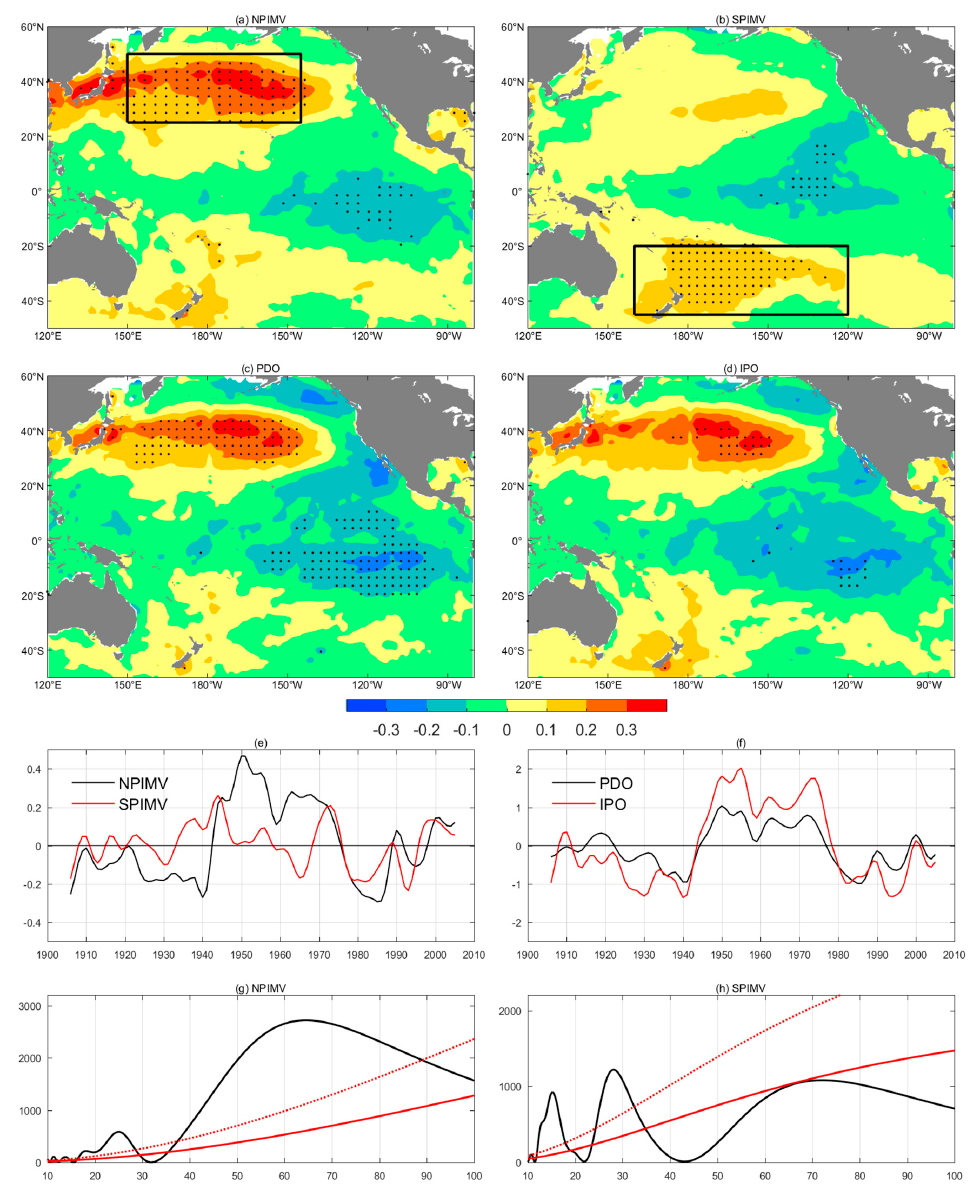
Figure 2. Regressions of SST anomalies onto ( a ) the NPIMV index, ( b ) the SPIMV index, ( c ) the Pacific decadal oscillation (PDO) index, and ( d ) the interdecadal Pacific oscillation (IPO) index (unit: °C per standard deviation). Values exceeding 90% for the significance test are dotted. ( e ) Time series of the NPIMV (black curve) and SPIMV (red curve) indices (unit: °C). ( f ) Time series of the standardized PDO (black curve) and IPO (red curve) indices. The PDO and IPO indices are multiplied by ( − 1) in order to compare with NPIMV and SPIMV. Power spectrum of ( g ) the NPIMV index and ( h ) the SPIMV index are shown. In ( g ) and ( h ), the red solid curve is corresponding red noise spectrum and the red dotted curve shows 5% confidence upper limit of the red noise spectrum. The x -axis is period (unit: years) and the y -axis is power.